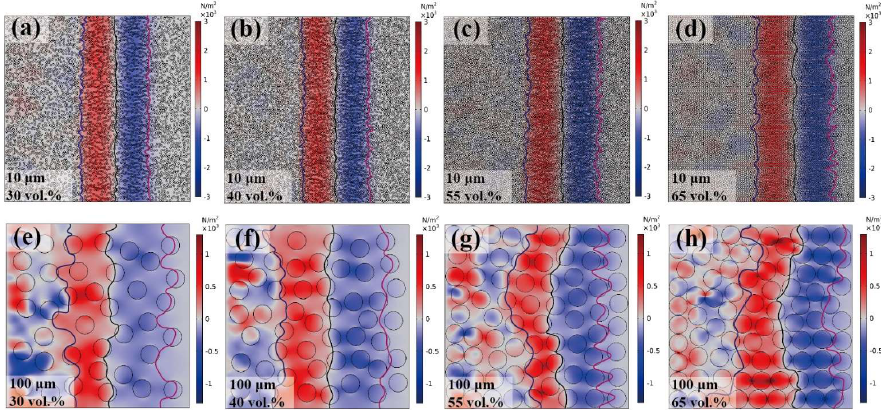
Figure 10. Stress distribution of elastic wave propagating behavior in Cu/PMMA composites: ( a – d ) particle size of 10 µm; ( e – h ) particle size of 100 µm .